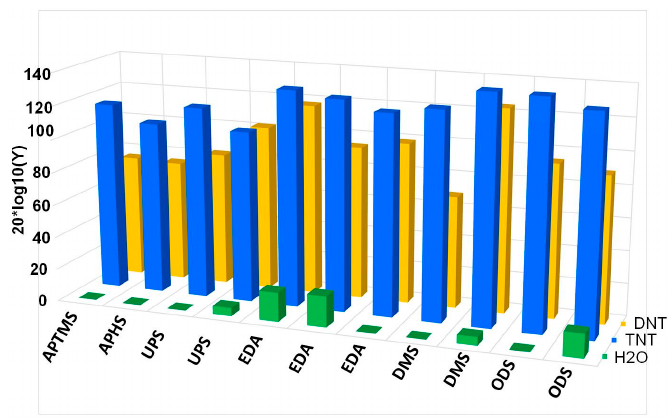
Figure 19. Scaled responses of differently modified sensors to H 2 O, TNT and DNT molecules at vapour pressure. Scaled response to H 2 O molecules is attenuated by factor greater than more than 10 5 (100 dB) in the worst case.